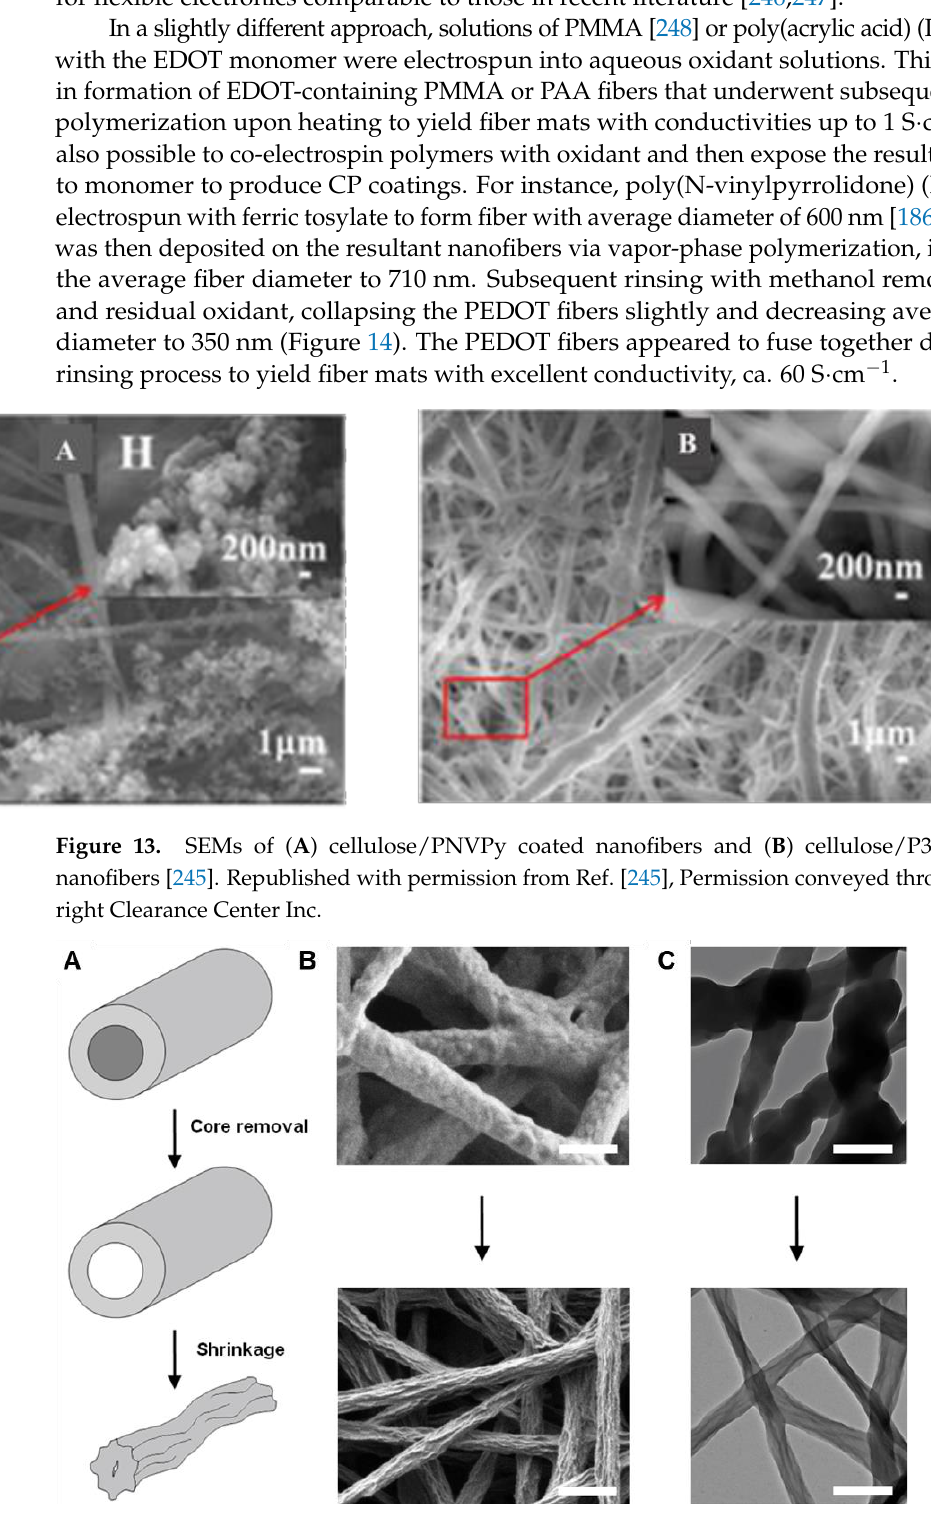
Figure 14. Polyvinylpyrrolidone electrospun with ferric tosylate and coated with PEDOT is rinsed with methanol to form hollow PEDOT nanofibers that collapse somewhat and fuse together [186]. ( A ) Process upon rinsing with methanol. ( B ) SEM and ( C ) TEM of the nanofibers. All scale bars represent 1 μm. Reprinted with permission from Ref. [186] .